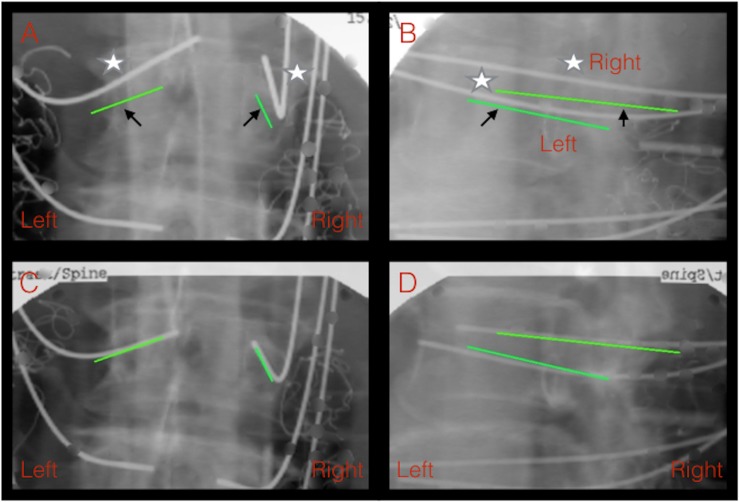
K-wire placement under the assistance of the robot before and after reregistration.A patient with lumbar spondylolisthesis received instrumentation from L3 to L5, and malpositioned bilateral L3 K-wires were noted initially. Fig 4A and 4B depict both left and right K-wire malpositions (Classification III) from the planned trajectory, as shown in the anteroposterior view (Fig 4A) and oblique view (Fig 4B). Fig 4C and 4D depict improved accuracy from classification type III to type I after the reregistration and adjustment of the K-wire placement.(Black arrow: planned trajectory; white star: implanted K-wire; green line: planned trajectory)